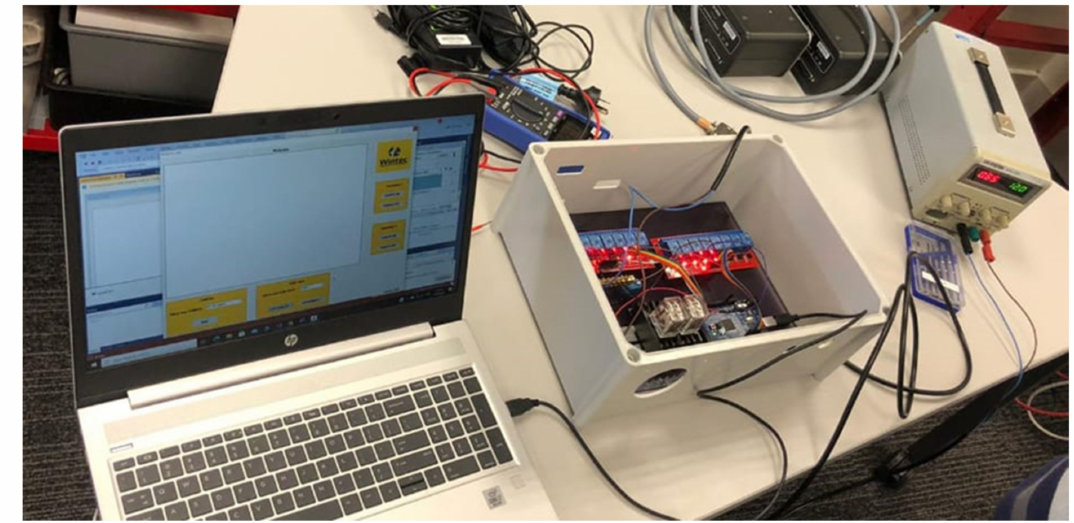
Figure 16. Testing the GUI program controlling the 8-channel relays via the micro-controller.